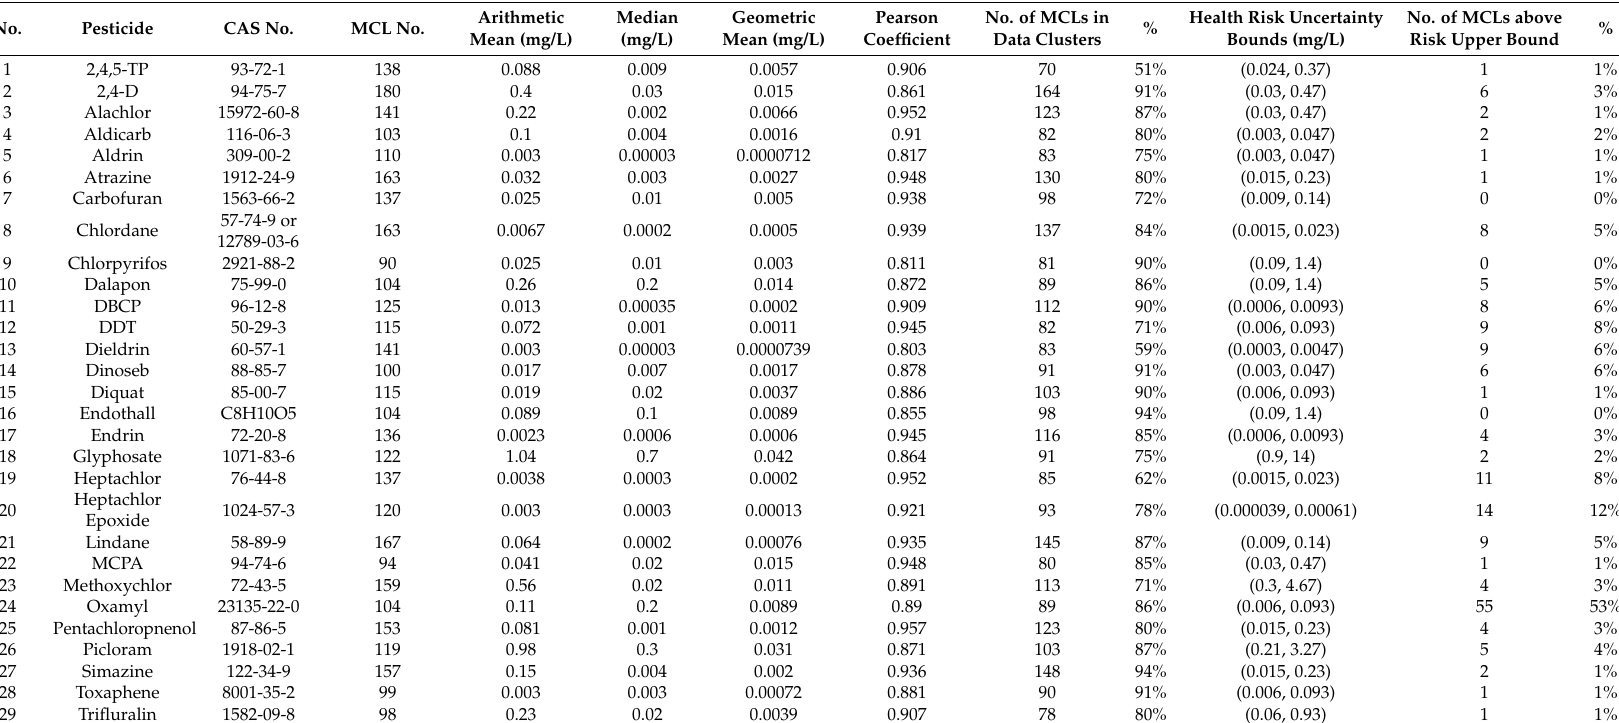
Table 6. Statistical summary of the MCLs for the commonly regulated